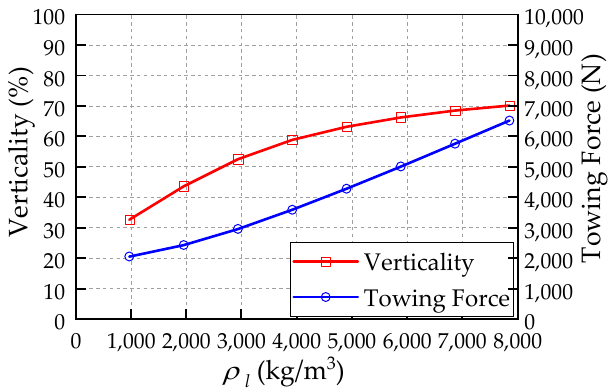
Figure 11. Verticality and towing force vs. towline material density.